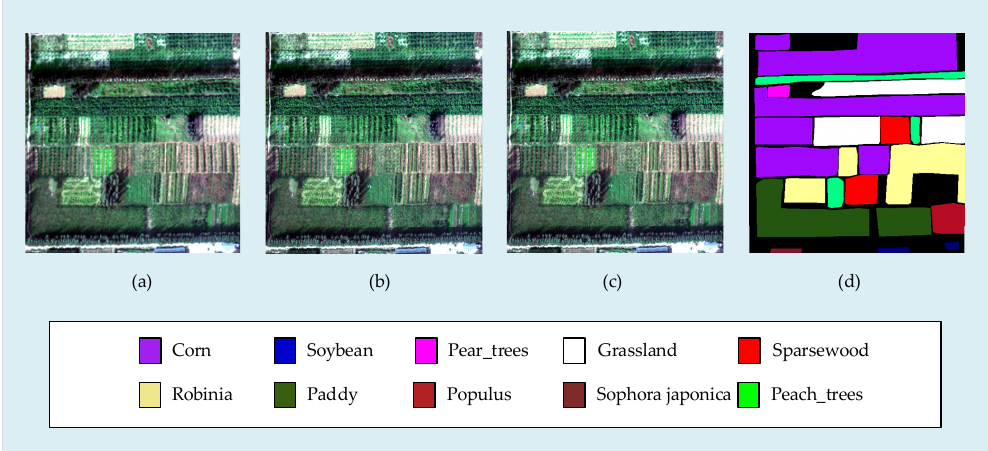
Figure 13. ( a ) The pseudo-colour image of Spectral_resolution_1 (2.4 nm); ( b ) The pseudo-colour image of Spec- tral_resolution_2 (4.8 nm); ( c ) The pseudo-colour image of Spectral_resolution_3 (9.6 nm); ( d ) ground truth classification map.